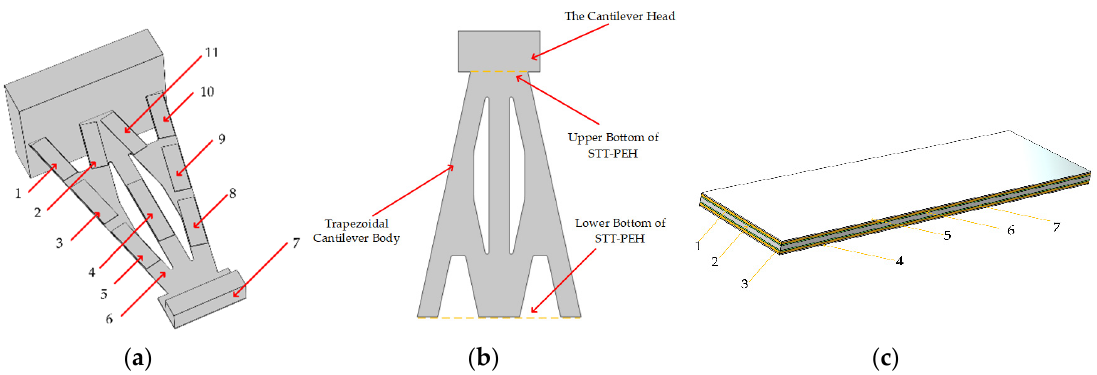
Figure 1. The structure of the STTM-PEH, T-shaped trapezoidal cantilever beam and piezoelectric patch. ( a ) 1,2,3,5,8,9,10,11—piezoelectric patches (piezoelectric layer: PZT-5H); 4—long piezoelectric patch (piezoelectric layer: PZT-5H); 6—T-shaped trapezoidal cantilever beam (copper); 7—mass (structural steel). ( b ) Structure of T-shaped trapezoidal cantilever beam. ( c ) 1,3—electrode; 2—piezoelectric material; 4,5—insulation layer; 6,7—conductive adhesive layer. Table 1. Structural sizes of T-shaped trapezoidal cantilever beam and mass. Heading Size ( 𝐦𝐦 ) Heading Upper bottom of trapezoidal cantilever body Lower bottom of trapezoidal cantilever body